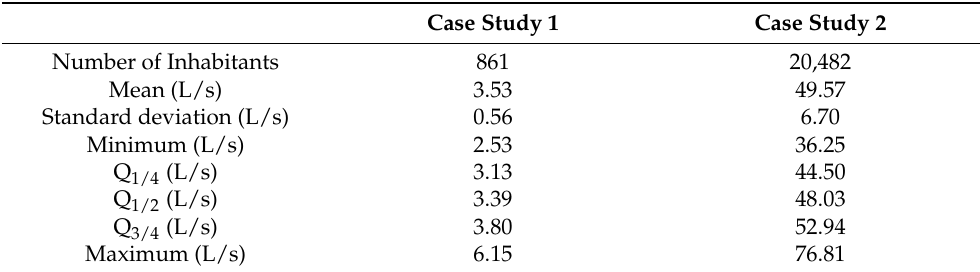
Table 1. Summary of observed data of the two case studies.